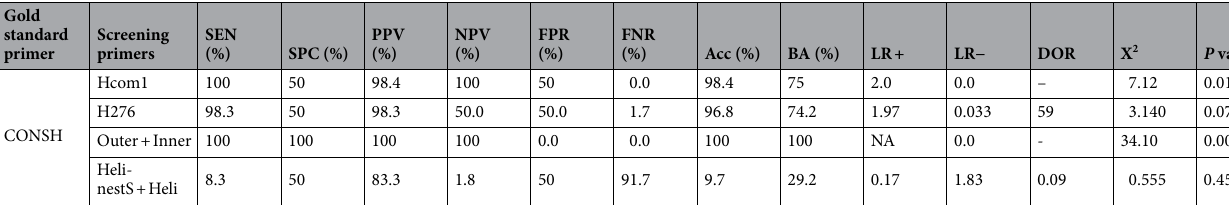
Table 3. Screening primers test results of In silico PCR for detection of 62 Helicobacter strains. SEN: sensitivity; SPC: specificity; PPV: Positive predictive value; NPN: Negative predictive value; FPR: False positive rate; FNR: False-negative rate; ACC: Accuracy; BA: Balanced accuracy; LR + : Positive likelihood ratio; LR−: Negative likelihood ratio; DOR: Diagnostic odds ratio. 16S rRNA, hspG, and Heid primers tested negative in